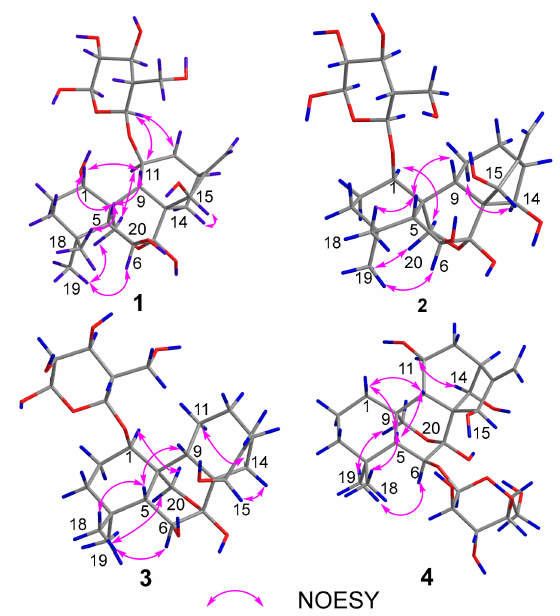
Figure 3. Key NOESY correlations of Compound 1 – 4 .